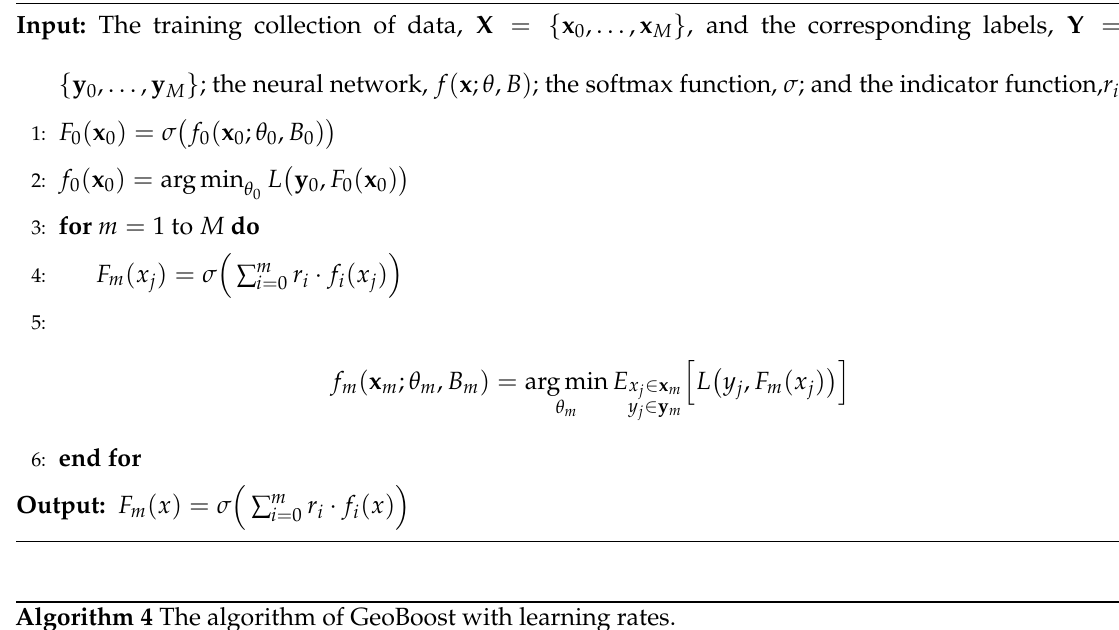
Algorithm 3 The algorithm of GeoBoost.